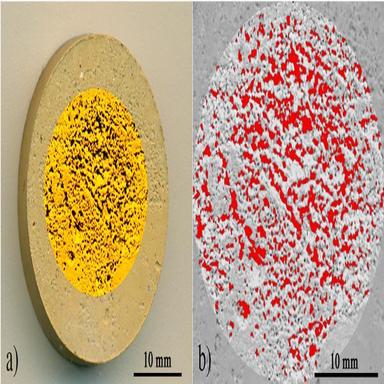
Image of the refractory sample after cavitation erosion illustrating the data extraction procedure: a) defined area of interest, b) extracted damaged shapes prepared for image analysis.